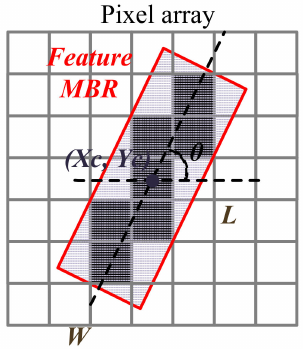
Figure 6. Minimum bounding rectangles (MBR) of a